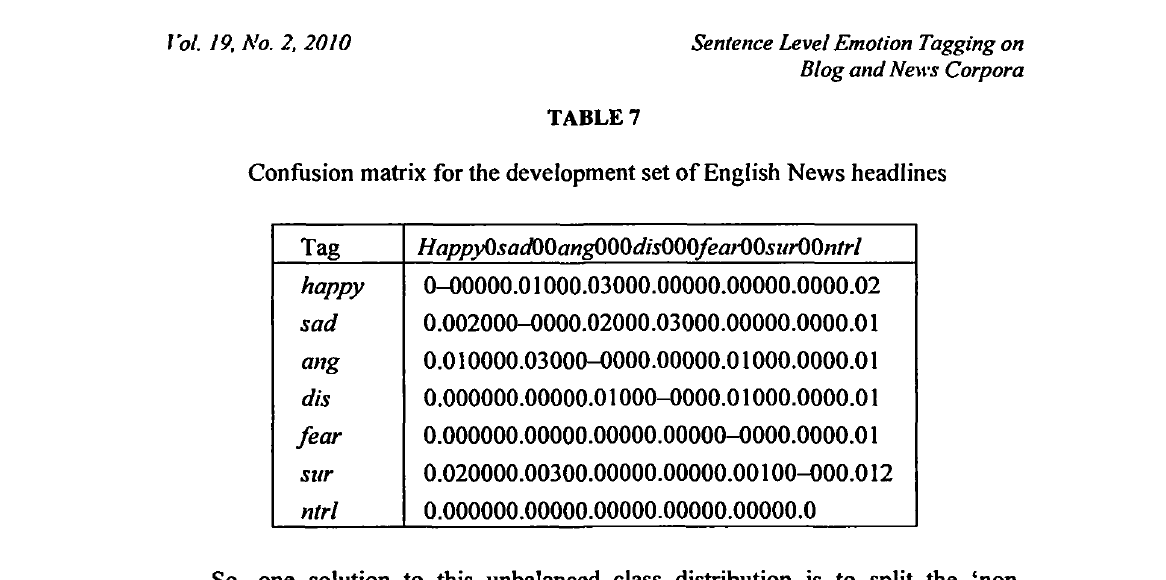
Confusion matrix for the development set of English News